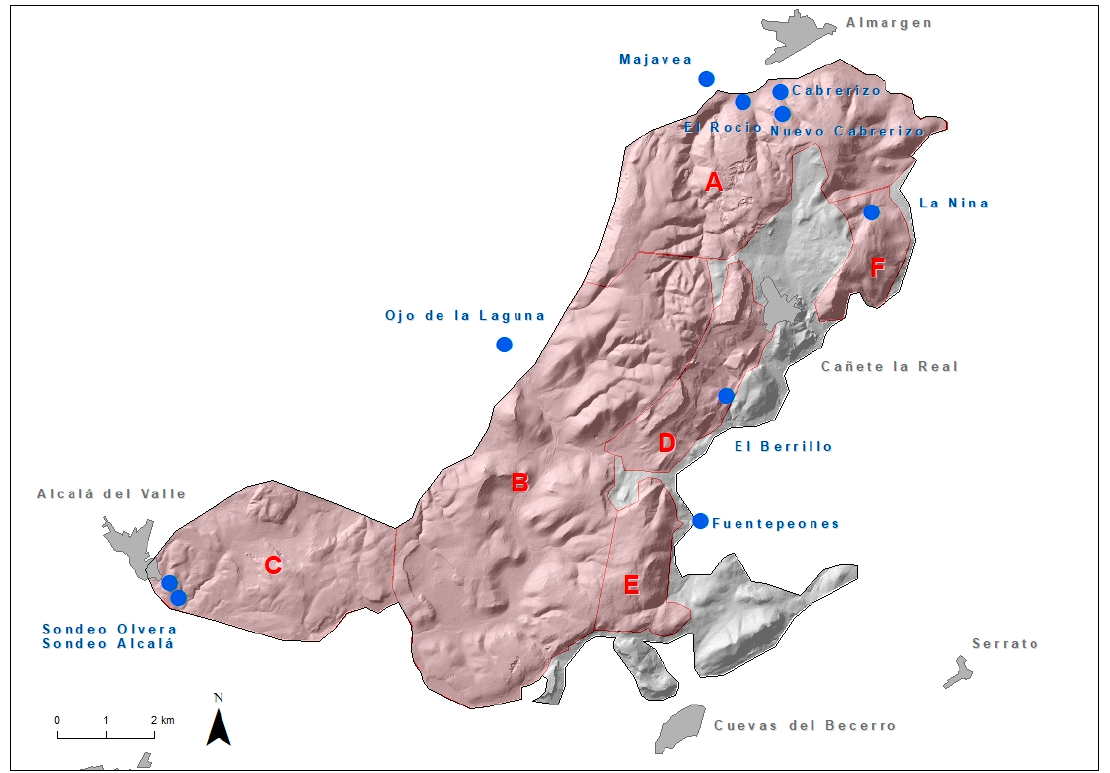
Figure 11. Contributing catchments areas in Sierra de Cañete.